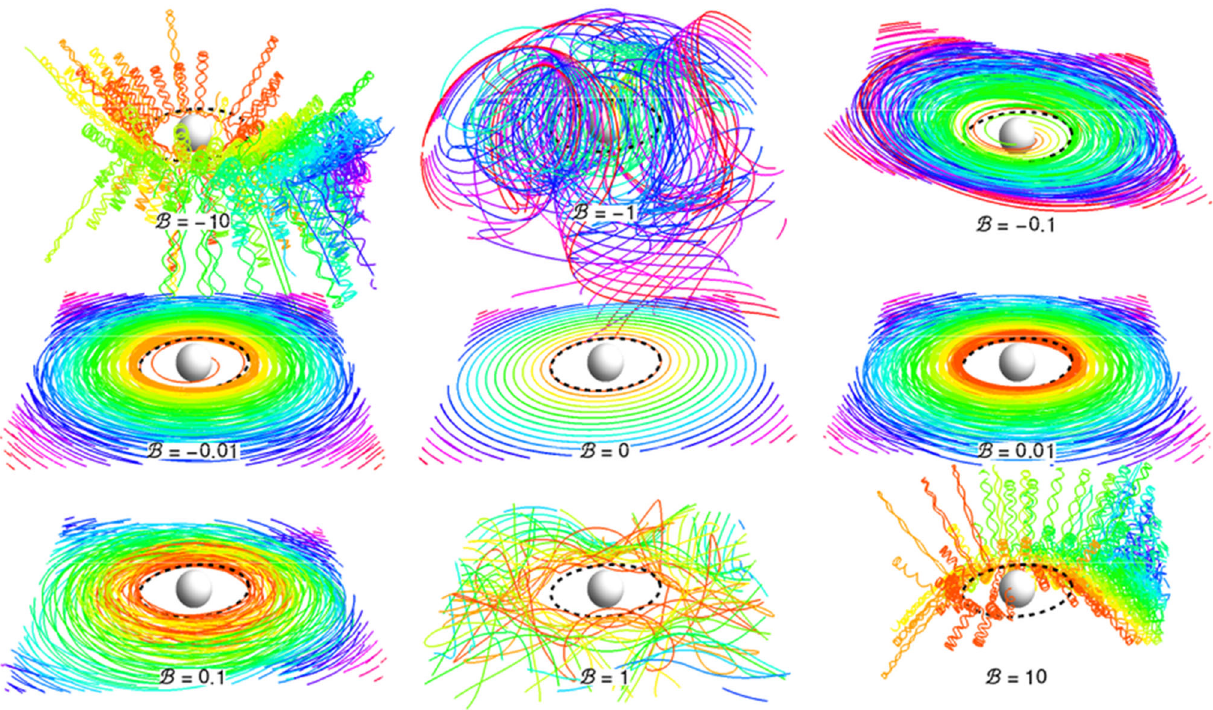
Fig. 12 Evolution of thin Keplerian accretion disks around Schwarzschild BH immersed into external parabolic MF. Initially, the particles from accretion disk follow circular geodesics with slight inclination from the equatorial plane ( θ 0 = 1 . 5), while the MF is directed along the z -axis. We set the declination parameter of the parabolic MF lines to w = 3 / 4, radiation parameter to k = 10 − 5 , and the values for the MF parameter to B = {± 10 , ± 1 , ± 0 . 1 , ± 0 . 01 , 0 } . The black dashed closed curves are the innermost stable circular orbits for neutral test particles, indicating the inner edge of the Keplerian accretion disk. In the absence of the MF ( B = 0 case, middle figure), all the orbits remain in their circular shape and only the inclined razor-thin disk can be seen. If a slight EM interaction is switched-on ( B = ± 0 . 01 cases, middle row), the charged particles creating a disk